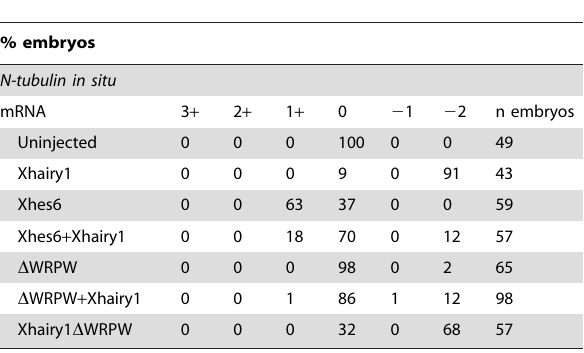
Table 6. Effect of Xhes6 on Xhairy1 activity.